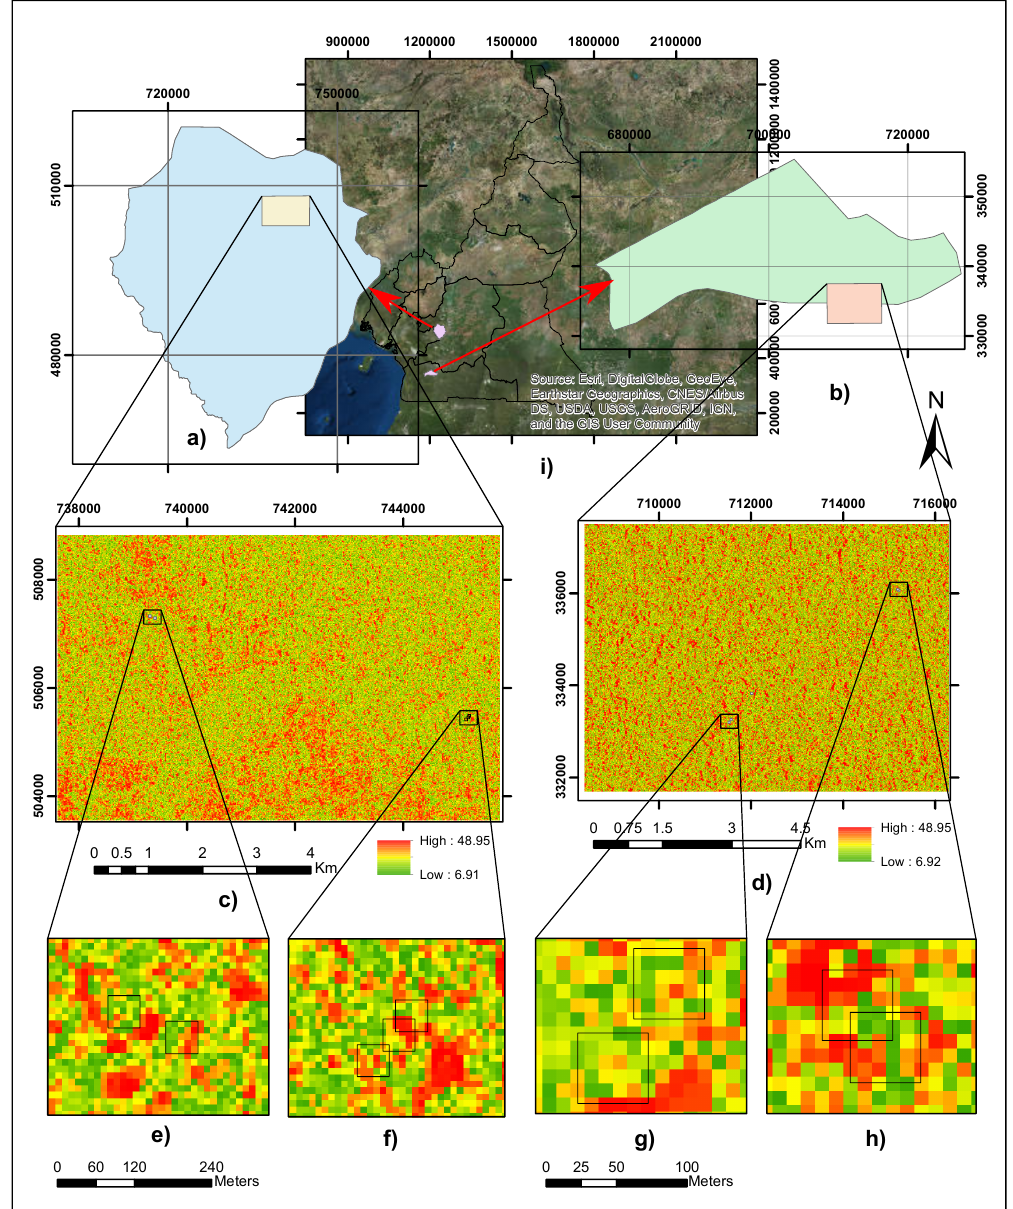
Figure 12. Canopy cover mapsbased on predictions from the RF regression algorithm (contrast improved by histogram equalization): ( a ) Study site in Bokito District. ( b ) Study site in Efoulan District. ( c ) Canopy gap fraction prediction in the Bakoa-Guefige landscape based on S-1A SAR image of 10 November 2017 (mean: 19.81%, SD: 10.09%). ( d ) Canopy gap fraction prediction in the Minkane-Minto landscape based on S-1A SAR image of 27 November 2017 (mean: 17.49%, SD: 8.70%). ( e – h ) Snips of some field sample areas. ( i ) Location of the study sites in Cameroon (source: WRI database and World imagery base